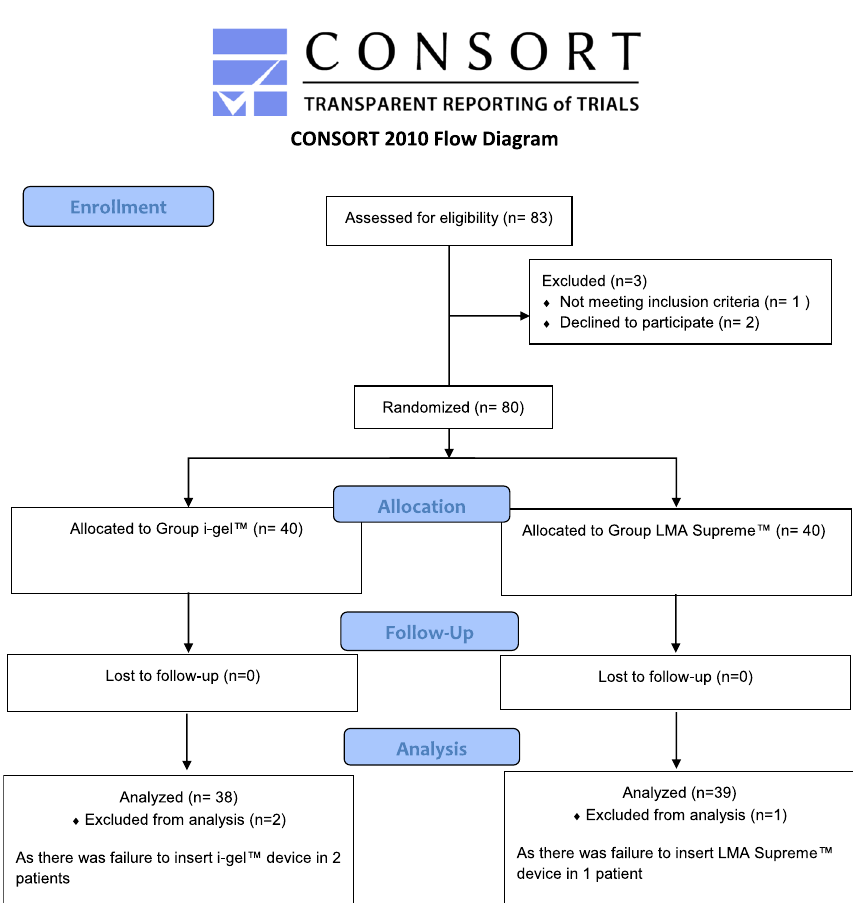
Fig. 1 Denotes the consort flow diagram. Participant eligibility, enrolment, and analysis are depicted. CONSORT indicates Consolidated Standards of Reporting Trials